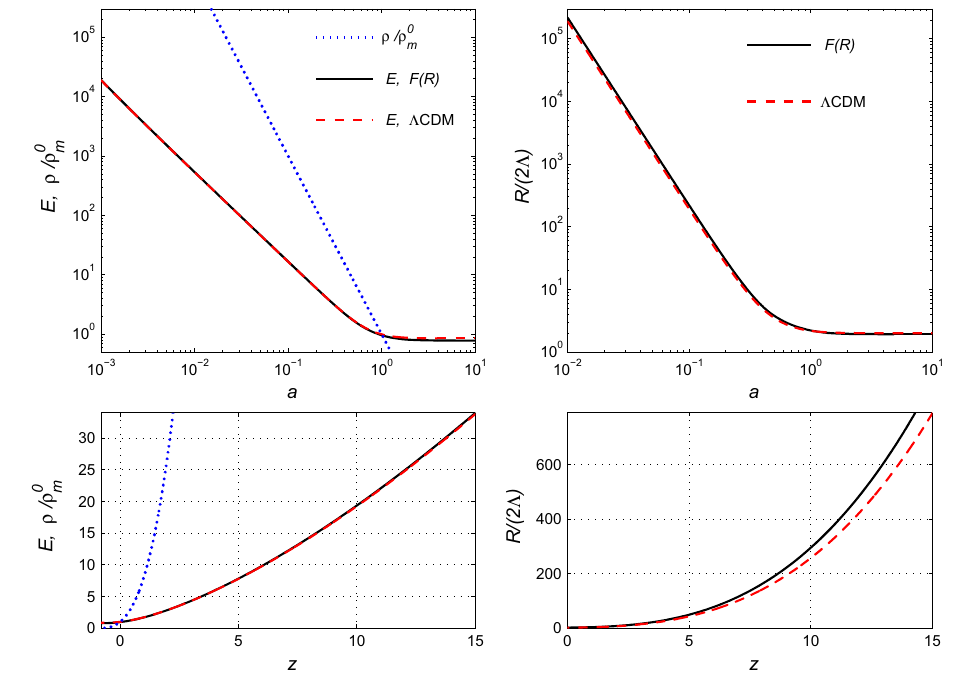
Fig. 3 Thetoppanelsinthelogarithmicscaleillustratethedependence of E = H / H (cid:2) CDM , ρ/ρ 0 m (the blue dots) and R = R /( 2 (cid:2)) on a for 0 the F ( R ) model (3.1) (the black solid lines) and for the (cid:2) CDM (the